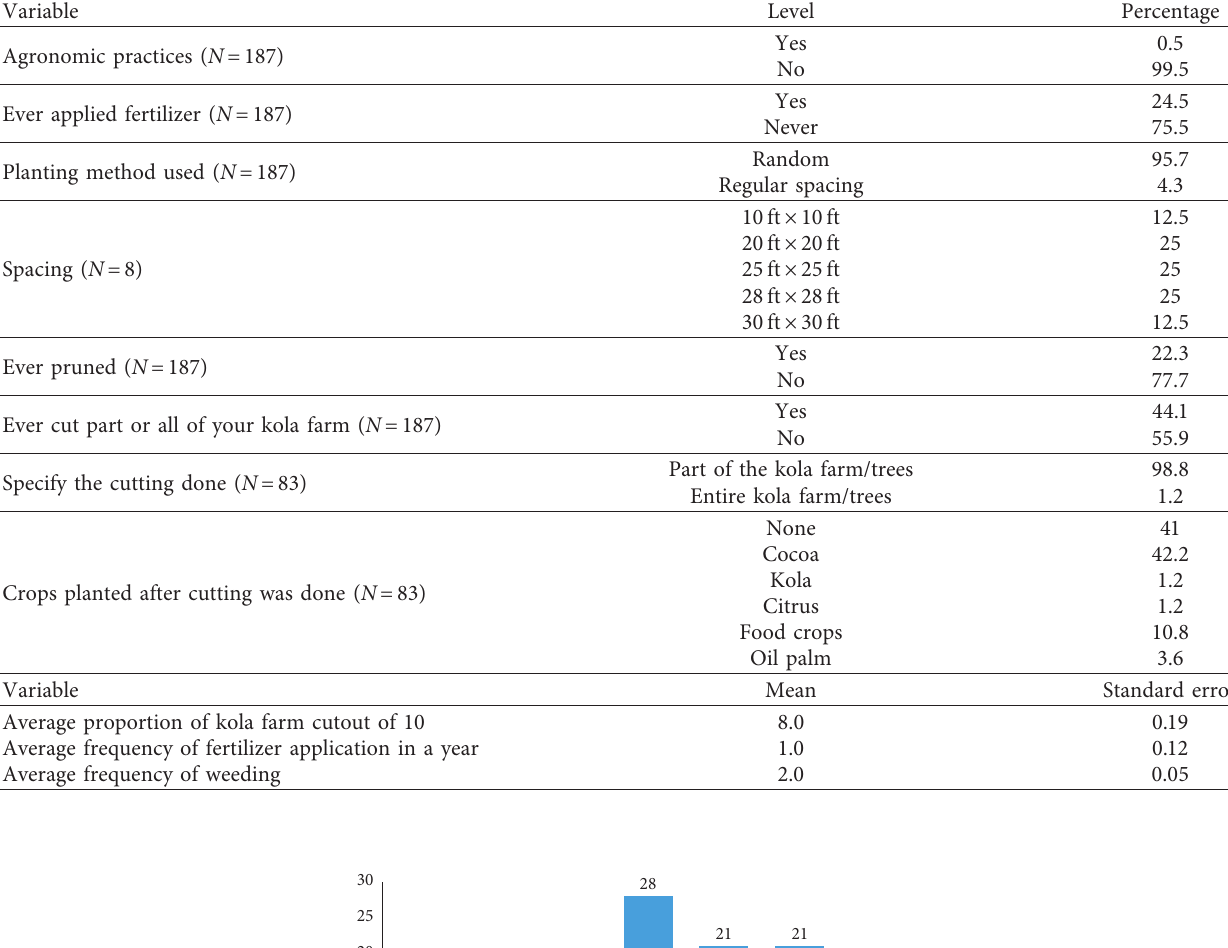
Table 4: Kola nut farmers’ cultural practices and extension.